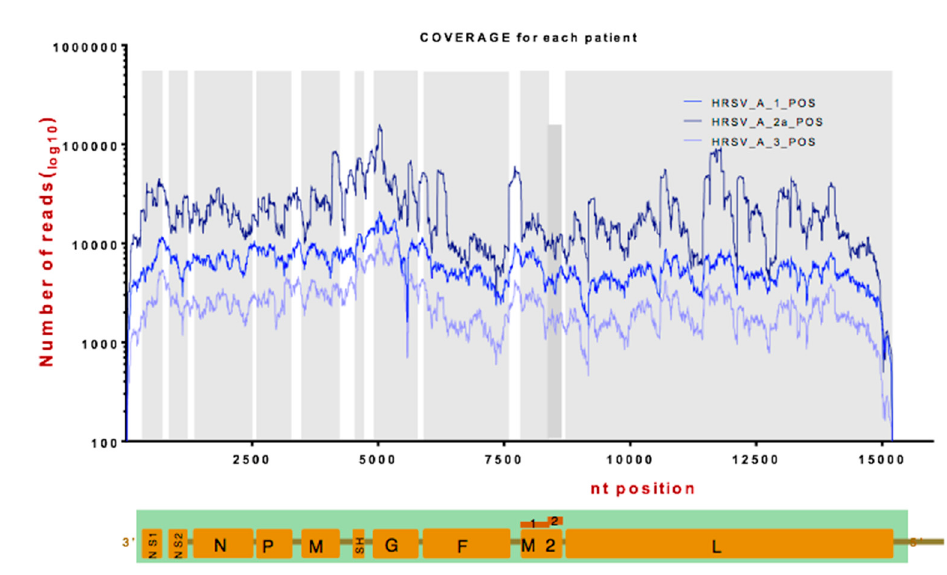
Figure 2. Depth of coverage for each nucleotide of sequence data for HRSV RNA mapped to the HRSV sub-group A2 genome from the three clinical samples (as indicated in the figure). The position of each nucleotide on the HRSV genome is shown on the x-axis with the virus genome and position of each genome as a reference shown below. The number of mapped reads is shown in logarithmic scale.